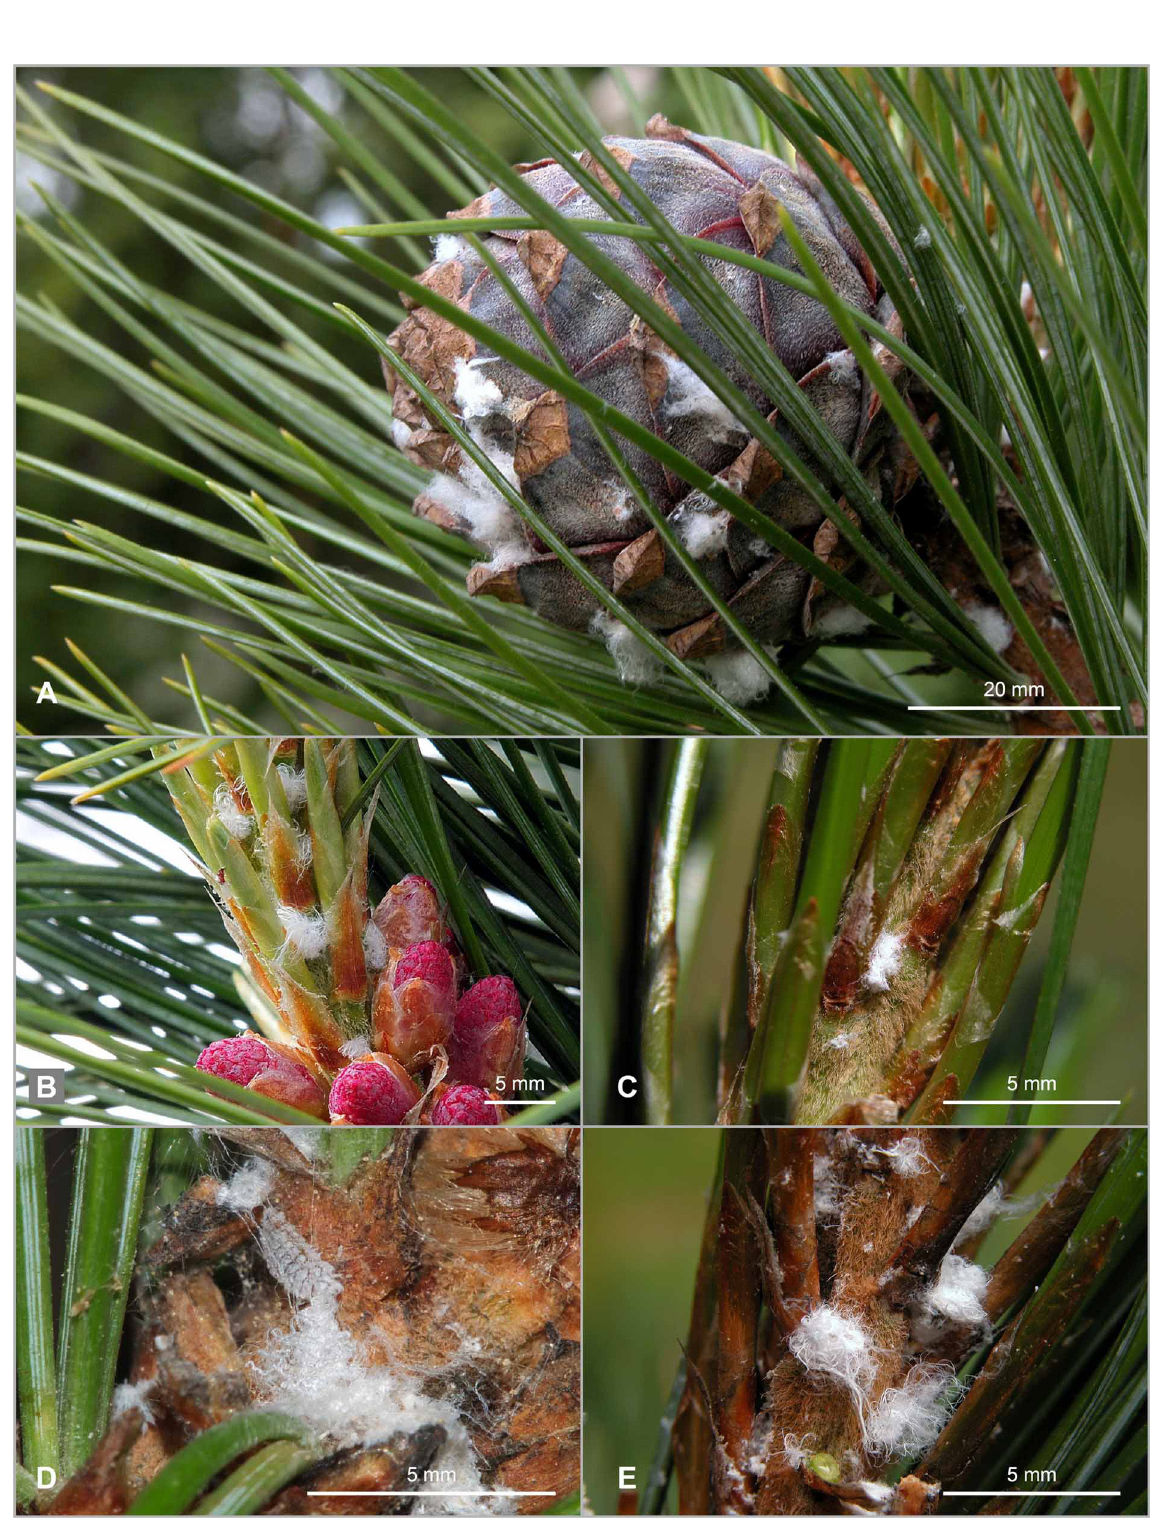
Fig. 77. Pineus (Pineus) cembrae (Cholodkovsky, 1888). Apterae on young growth of Pinus cembra . In D, also a scymnine ladybird larva (Coleoptera,